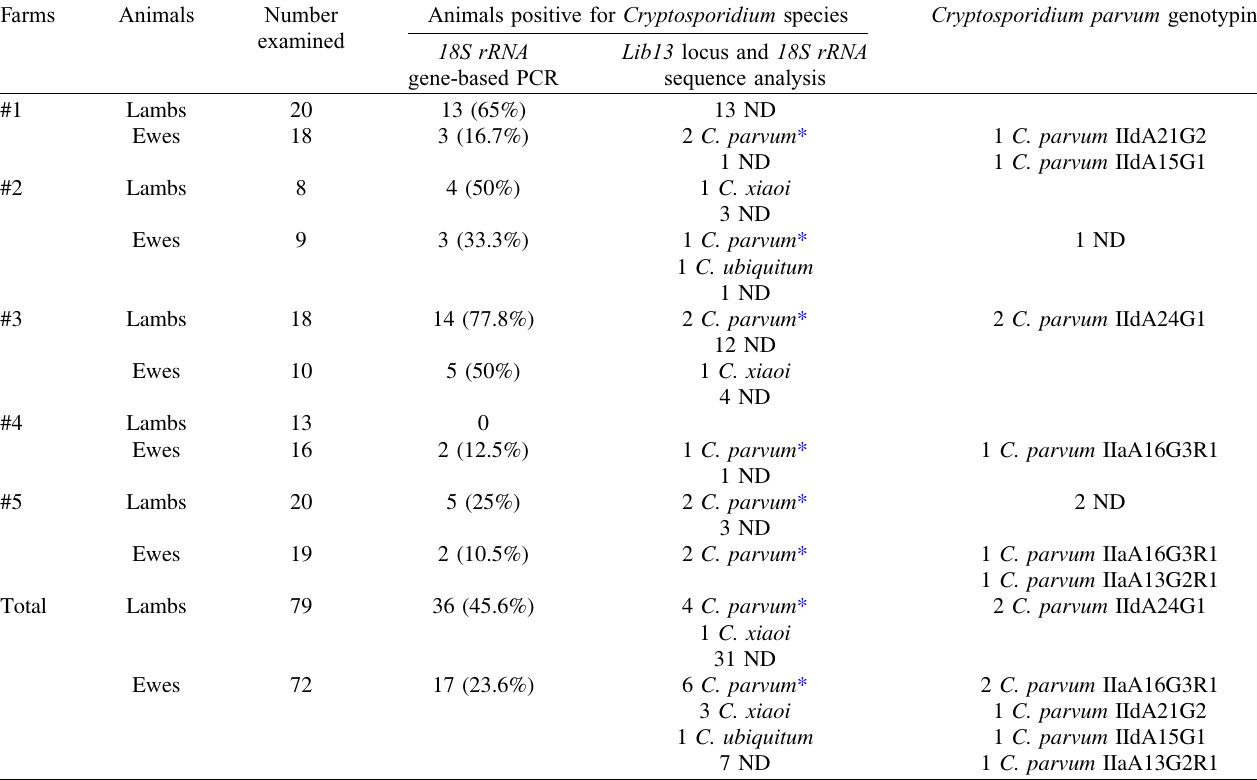
ND: not determined due to sequencing failure. * Determined by Lib13 PCR